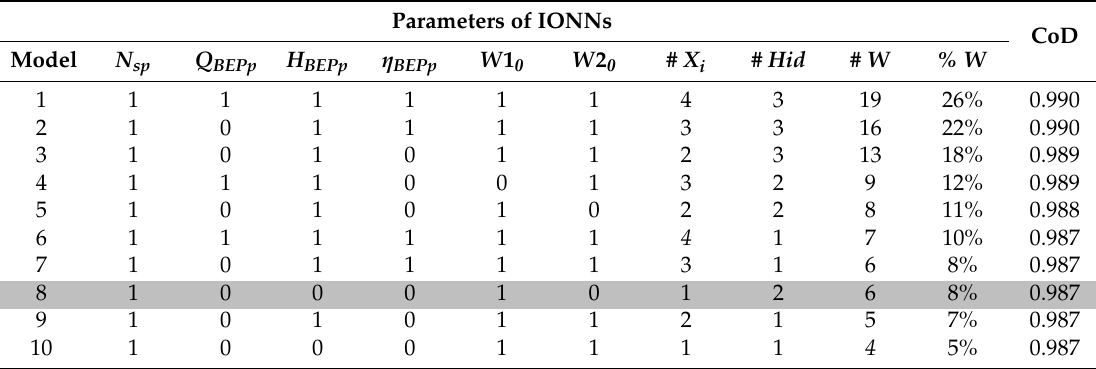
Table 2. Pareto front (min(neurons, inputs, 1 − CoD)) of IONNs for N st . Parameters of